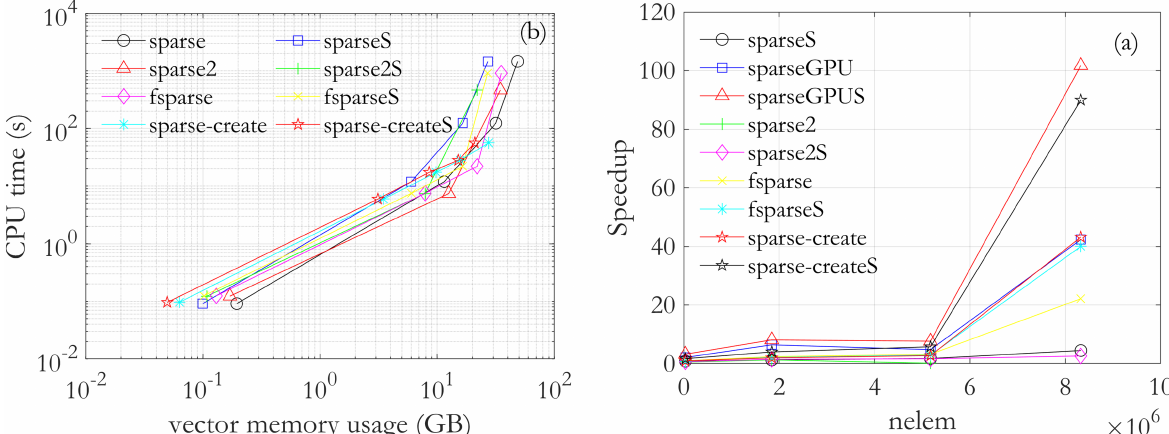
Figure 13. (a) Speedup of global KG array assembly in relation to CPU sparse (b) memory consumption versus CPU